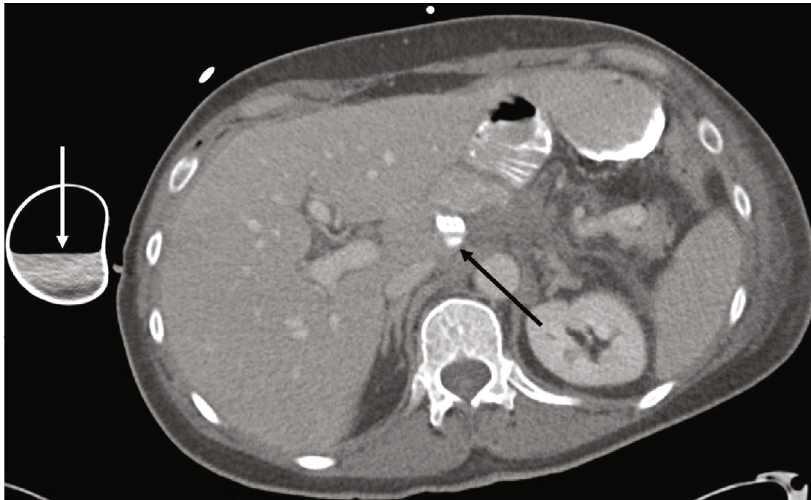
Figure 4: Axial postcontrast CT performed in the postoperative period showed leaked contrast concentrated at the tip of the surgical drain (black arrow). Contrast level is also present within Jackson-Pratt drain reservoir (white arrow).